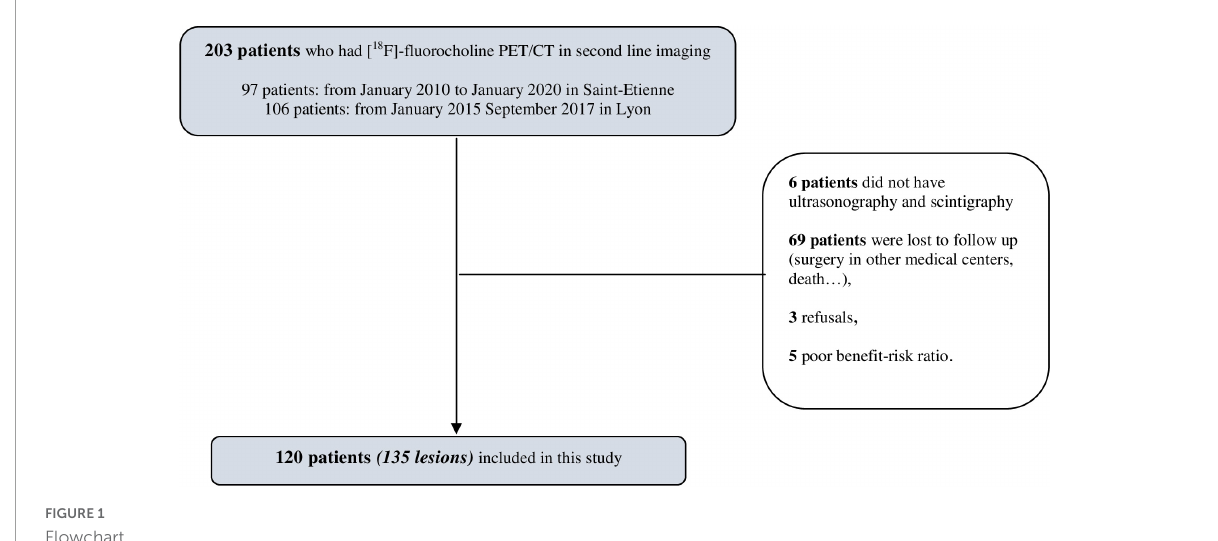
FIGURE1 Flowchart.